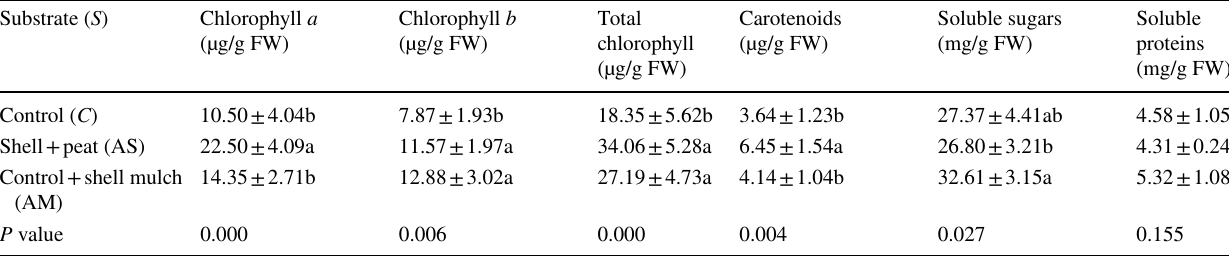
Table 4 Influence of the substrate on photosynthetic pigments content of green bean pods 60 days after sowing